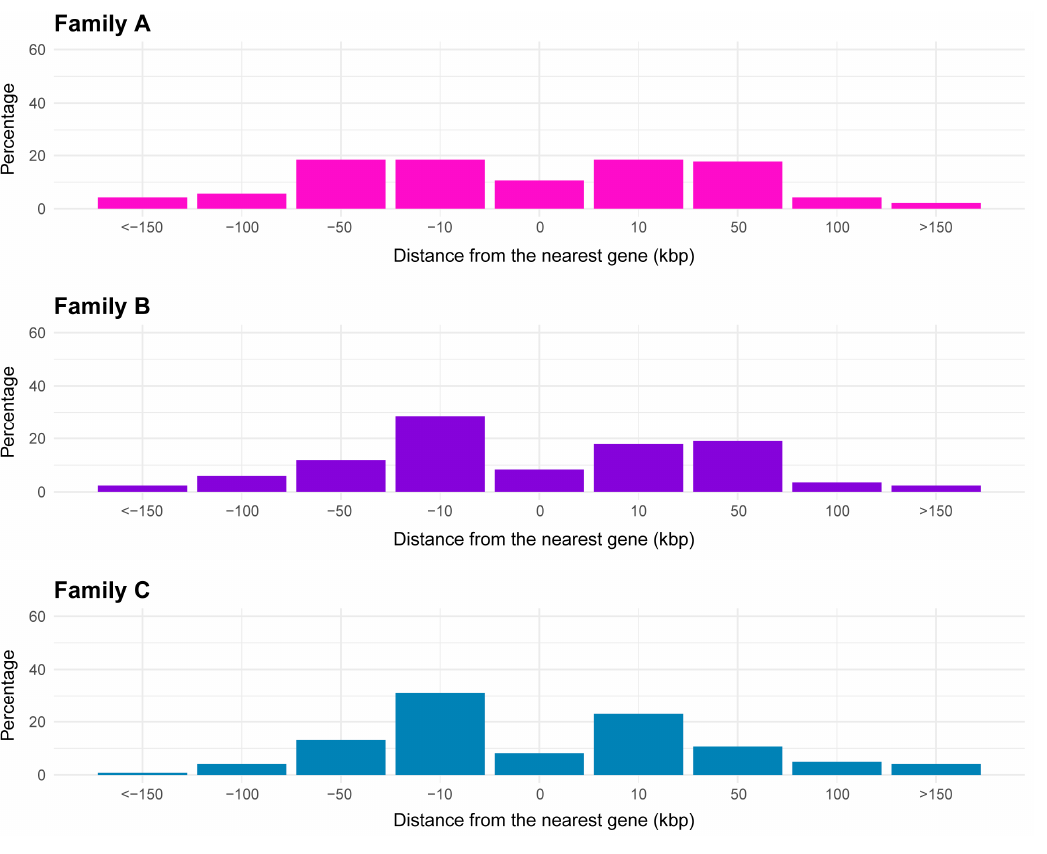
Figure 4. Bar plots reporting the proximity of CACTA TEs to the closest sunflower gene. Results are reported for families A, B, and C. Proximity to the closest gene is expressed in kilo base pairs (kbp).